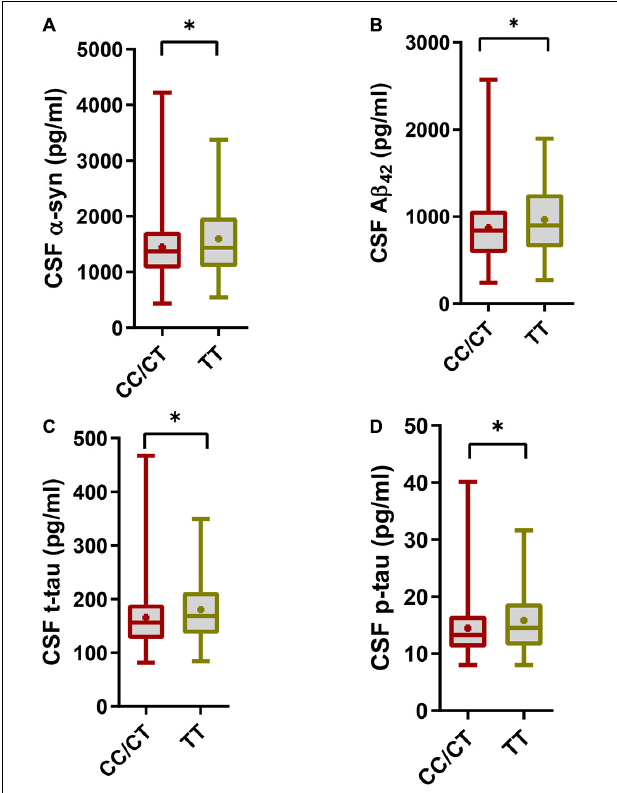
FIGURE 1 | Cerebrospinal fluid (CSF) pathology in the SNCA rs3910105 C allele group and TT group. (A) Difference in CSF α -syn levels between the rs3910105 C allele and TT groups [Unpaired t -test(two-tailed), t = 2.38, p = 0.019]; (B) differences in CSF A β 42 levels between the rs3910105 C allele and TT groups [Unpaired t -test(two-tailed), t = 2.43, p = 0.015]; (C) differences in CSF t-tau levels between the rs3910105 C allele and TT groups [Unpaired t- test(two-tailed), t = 2.47, p = 0.012]; (D) differences in CSF p-tau levels between the rs3910105 C allele and TT groups [Unpaired t -test(two-tailed), t = 2.31, p = 0.02]. ∗ P < 0.05. levels (165.3 ± 55.43 pg/ml vs. 180 ± 59.82 pg/ml; p = 0.012) ( Figure 1C ) and lower CSF p-tau levels (14.48 ± 5.124 vs. 15.80 ± 5.659, p = 0.02) ( Figure 1D ) than the TT